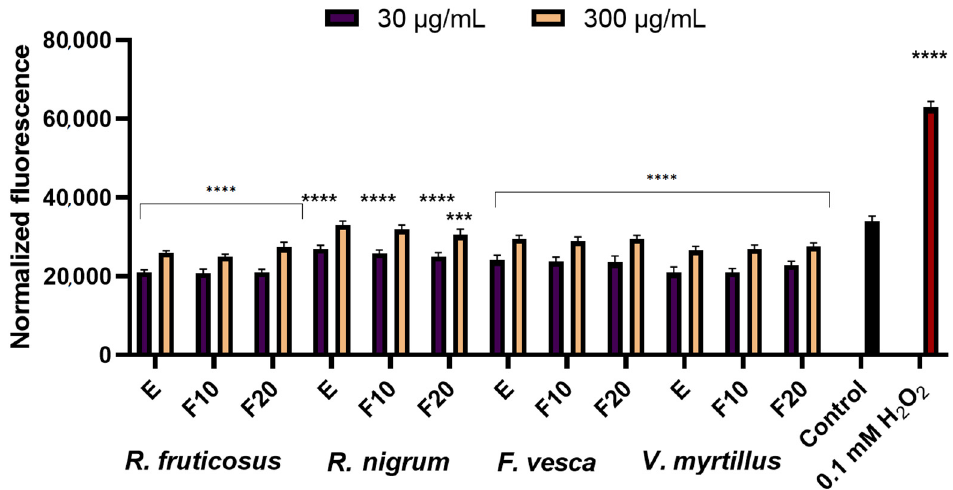
Figure 3. Effect of R. fruticosus L., R. nigrum L., F. vesca L., V. myrtillus L. extract and kombucha ferments (at concentrations of 30 µ g/mL and 300 µ g/mL) on the DCF fluorescence in keratinocytes (HaCaT). Data are the mean ± SD of three independent experiments, each consisting of three replicates per treatment group. **** p < 0.0001, *** p < 0.0004 versus the control.